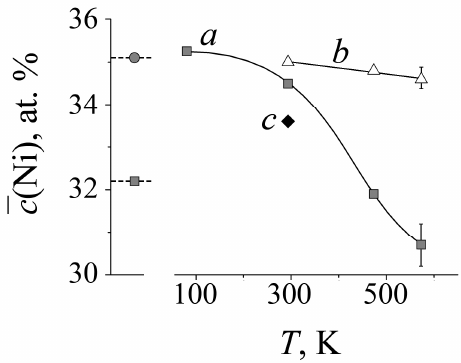
Figure 15. The effect of deformation temperature on the nickel concentration c ( Ni ) . ( a ) in austenite of the alloy Fe 55 Ni 36 Al 9 aged at 873 K for 3 h; ( b ) in the binary alloy Fe 64.9 Ni 35.1 ; ( c ) in austenite of the alloy Fe 55 Ni 36 Al 9 preliminarily aged at 873 K for 3 h after its HPT treatment with ε = 4.8 (1 rev.) and subsequent isothermal annealing at 573 K for 50 min. The round symbol corresponds to the value characteristic of the state obtained after quenching from 1373 K in water.